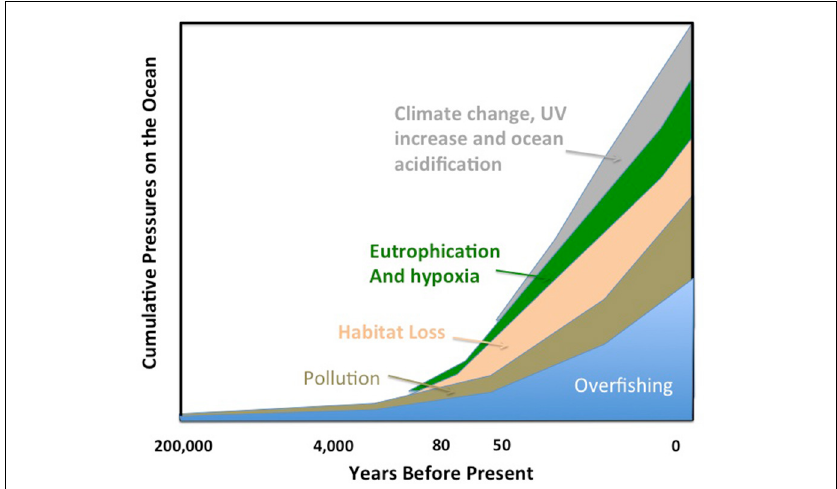
FIGURE 2 | A time line of cumulative pressures on the global ocean. The size of the polygons corresponding to each pressure is arbitrary and is not meant to reflect their objective